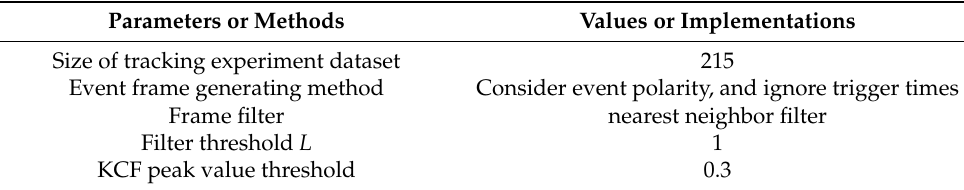
Table 4. Experimental parameters and dataset properties.